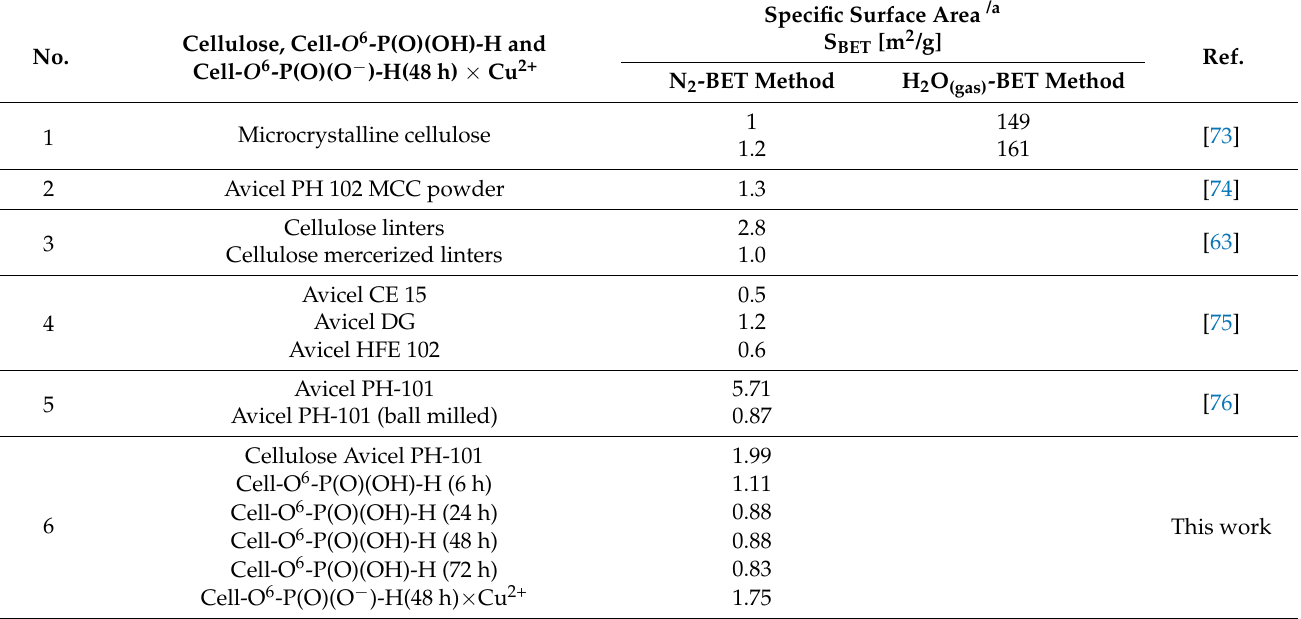
Table 10. Specific surface area (S BET ) determinations of the examined samples.